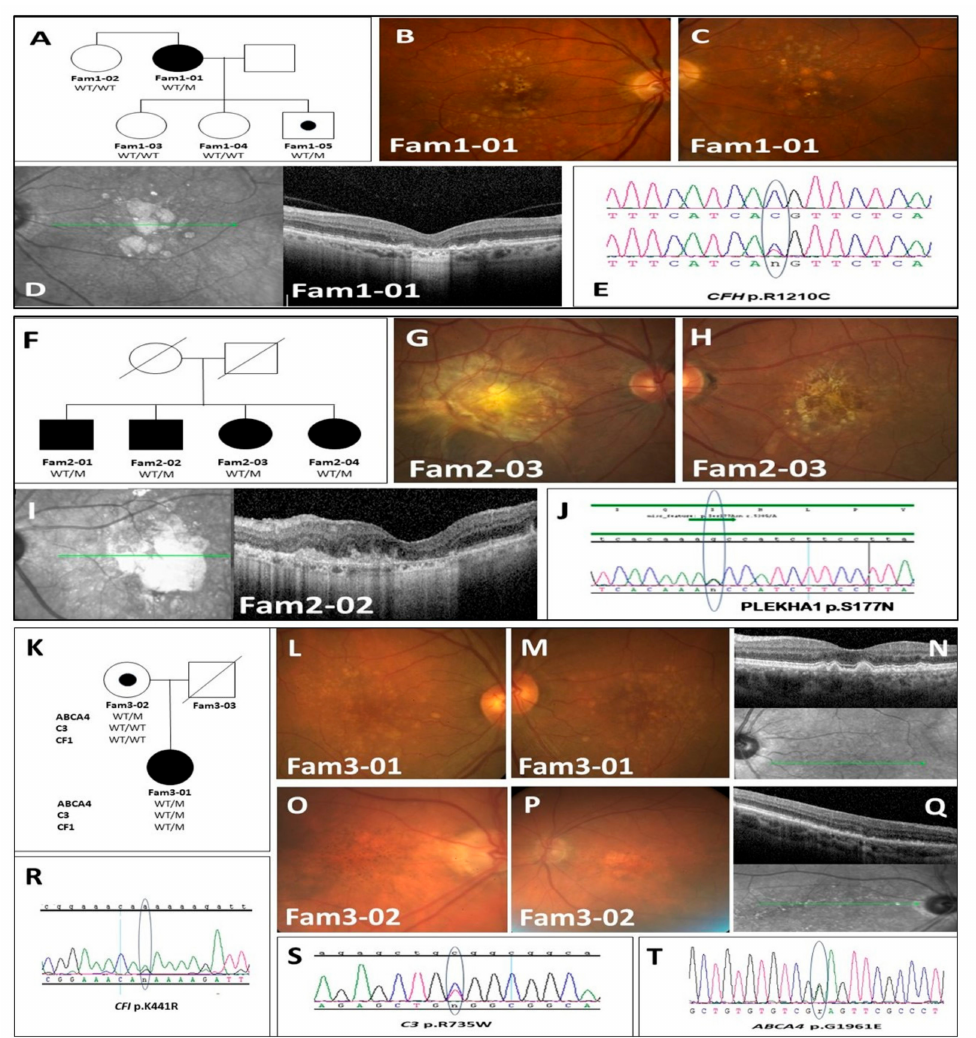
Figure 2. Family 1–3 pedigrees, clinical findings and sequencing results. ( A ) Family 1